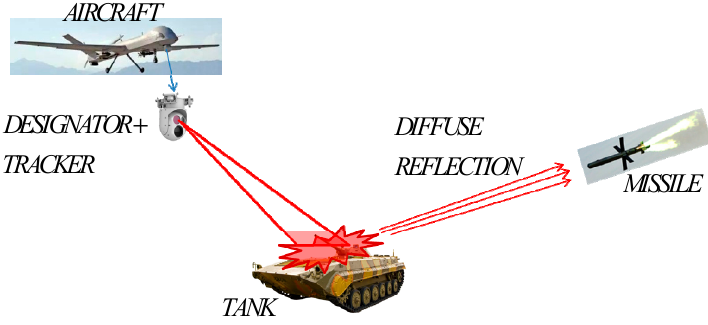
Figure 1. Schematic diagram of the laser semi-active guidance system.